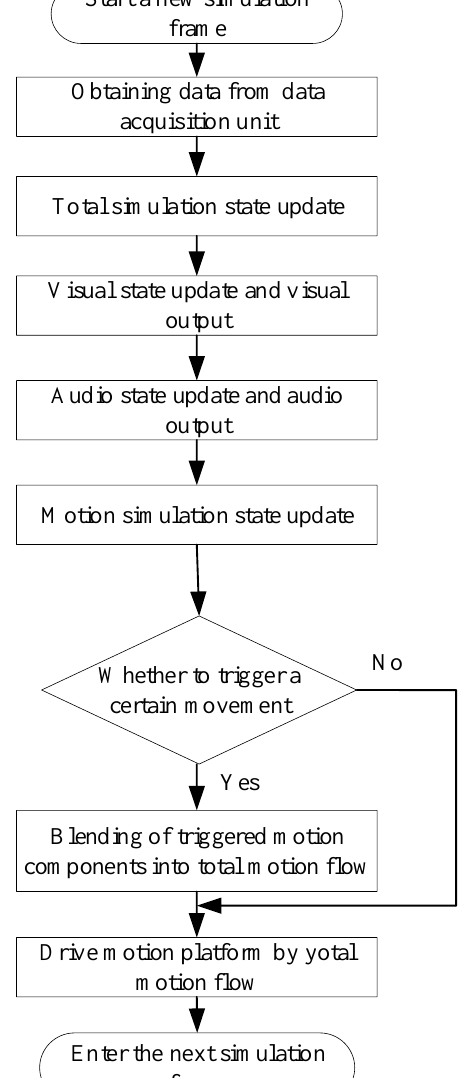
Figure 8. Algorithm flow of motion simulation based on streamlined motion blending.